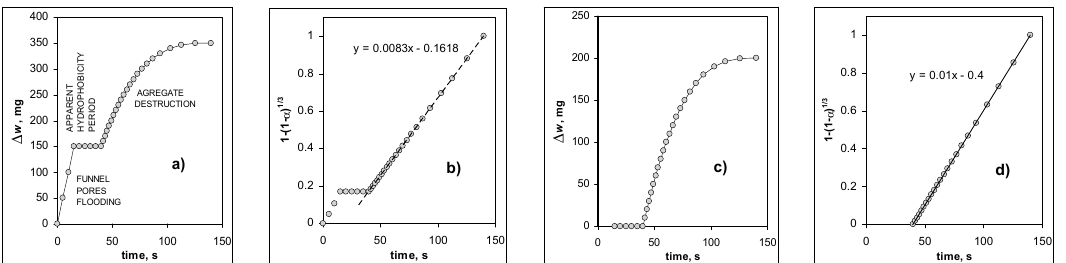
Figure 3. ( a ) Simulated destruction curve from Figure 2a including the apparent hydrophobicity period. ( b ) The plot of the above curve in coordinates of Equation (4). ( c ) The curve ( a ) after subtraction of the amount of air released from funnel pores ( FP ) from Equation (4), and ( d ) the plot of the curve ( c ) in coordinates of Equation (4).